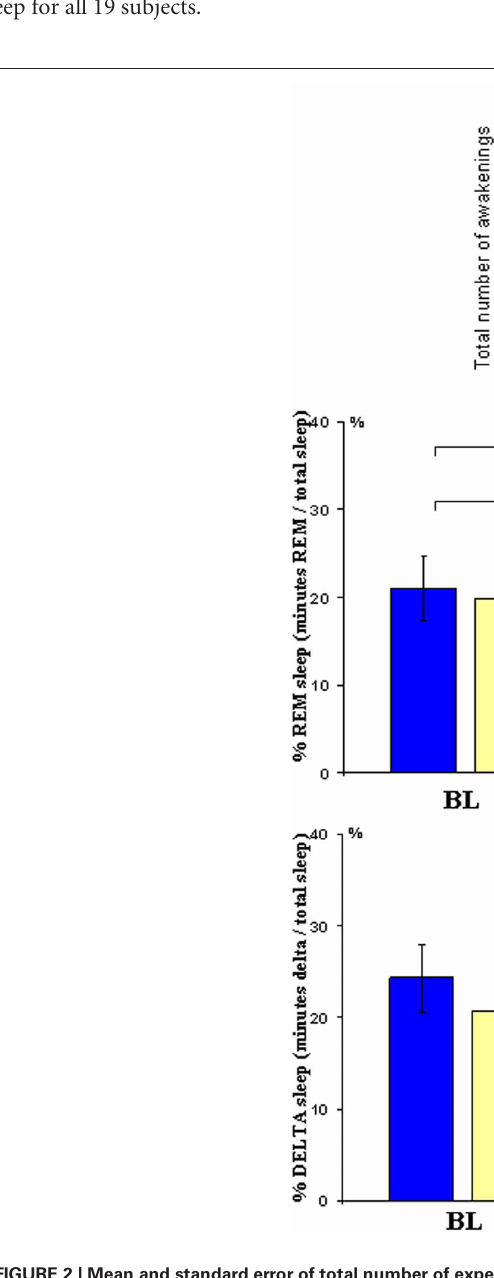
FIGURE 2 | Mean and standard error of total number of experimental awakenings during sleep manipulation night, and of percentage of REM sleep (minutes of REM/minutes total sleep) and delta sleep (minutes of stage3 + 4/min total sleep) at baseline (BL), experimental (EXP) and